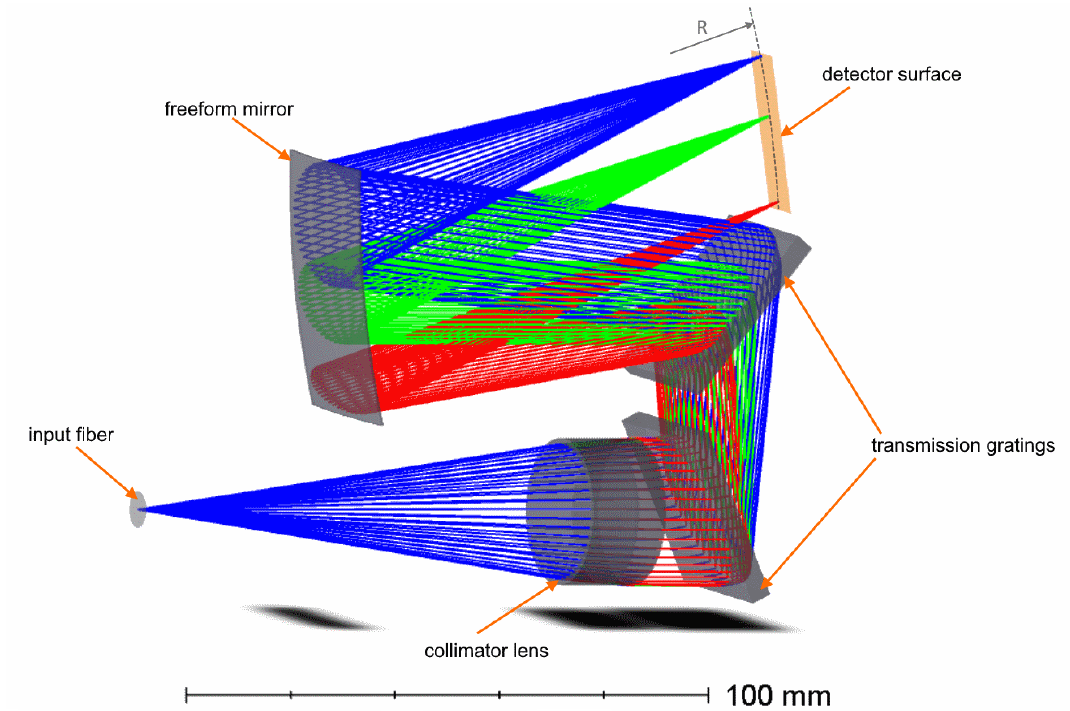
Figure 3. Optical design of the high-dispersion spectrograph with a pair of transmission gratings (Design